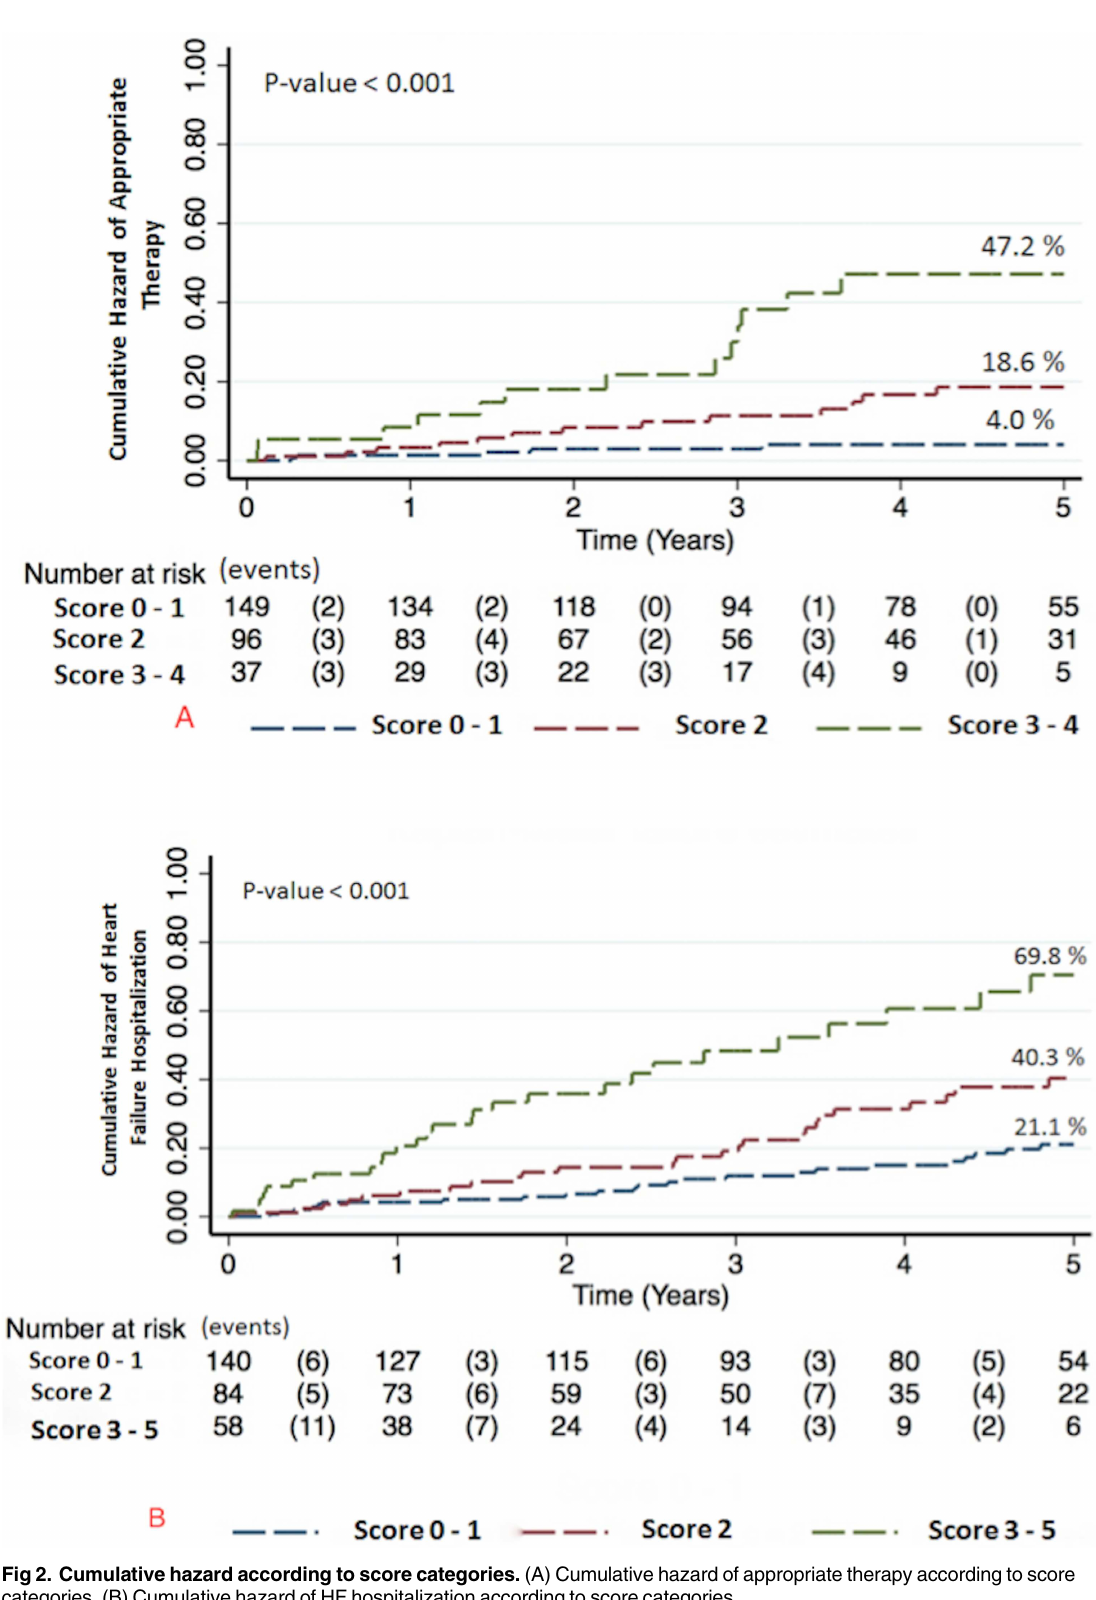
PLOS ONE | https://doi.org/10.1371/journal.pone.0175205 April 7,